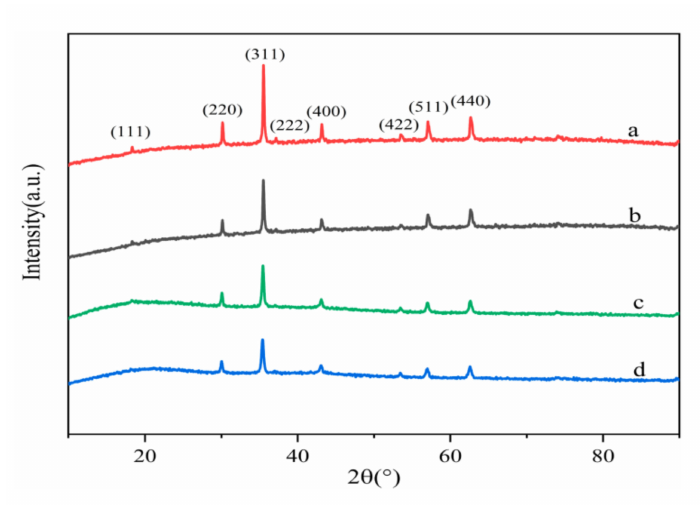
Figure 3. XRD patterns of Fe 3 O 4 ( a ), Fe 3 O 4 @SiO 2 ( b ), Fe 3 O 4 @SiO 2 / CS ( c ), and Fe 3 O 4 @SiO 2 / CS / GO / β -CD ( d ).